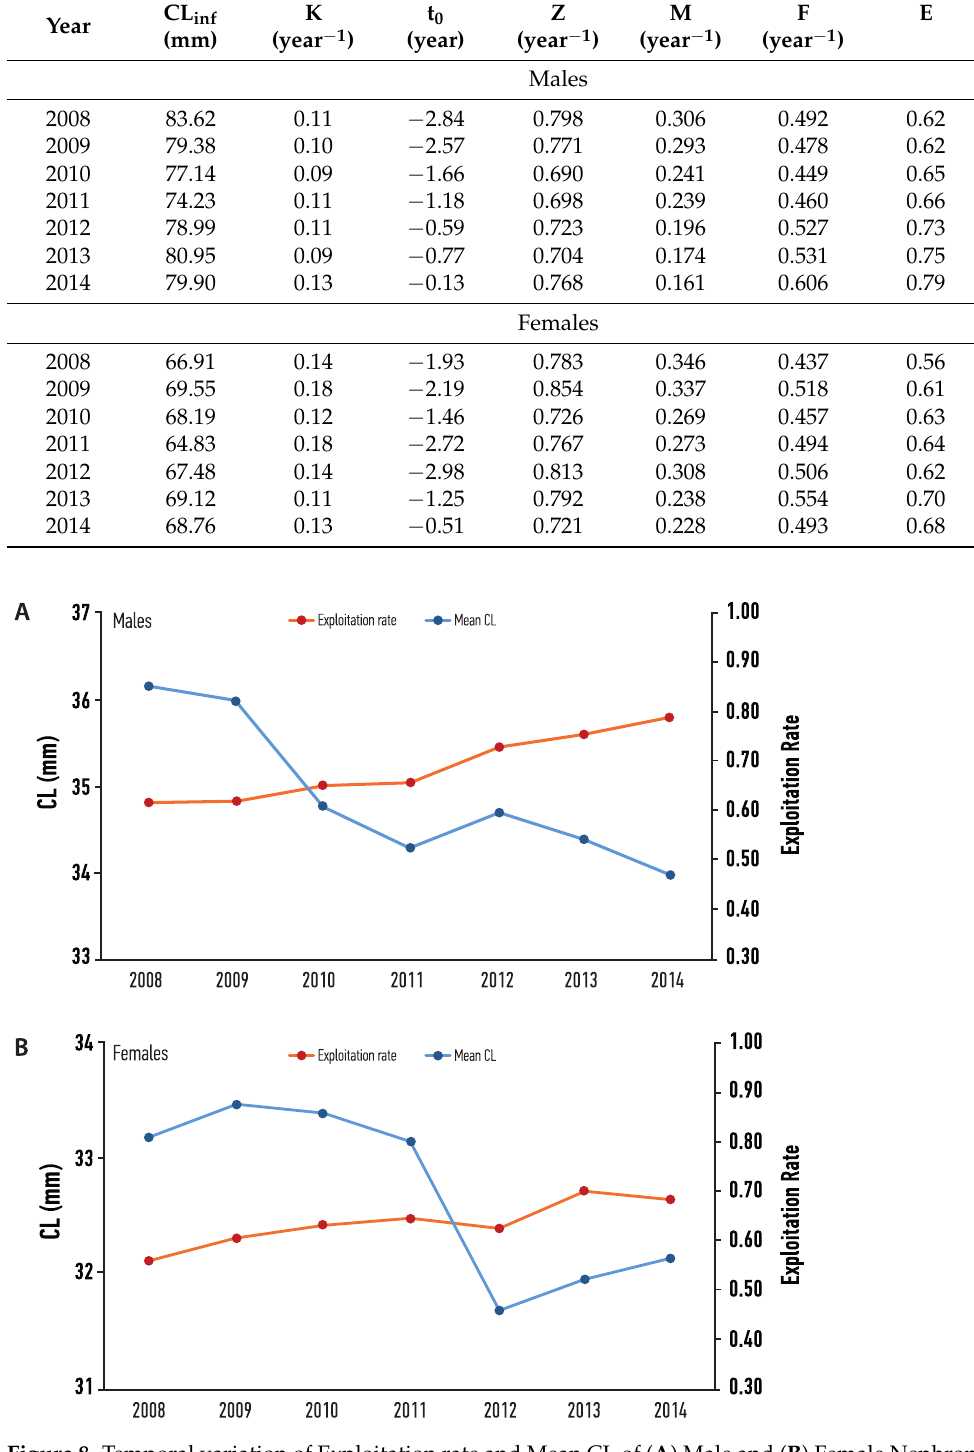
Figure 8. Temporal variation of Exploitation rate and Mean CL of ( A ) Male and ( B ) Female Nephrops from Pagasitikos Gulf, Eastern Mediterranean, Greece.